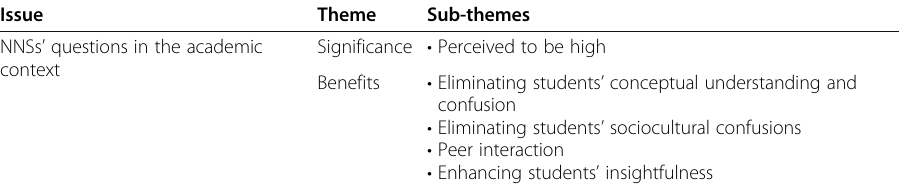
Table 4 TOEFL iBT instructors ’ perceptions of non-native students ’ questions in